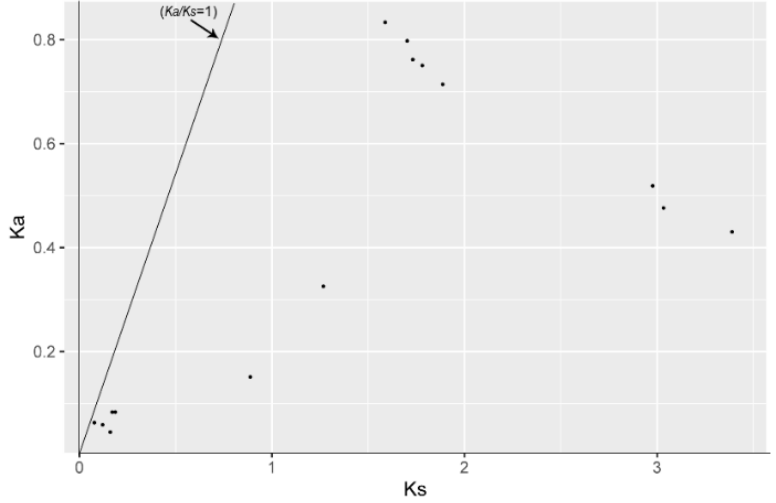
Figure 5. The Ka , Ks value of duplication gene pairs, and the Ka/Ks = 1 line was plotted in the graph.